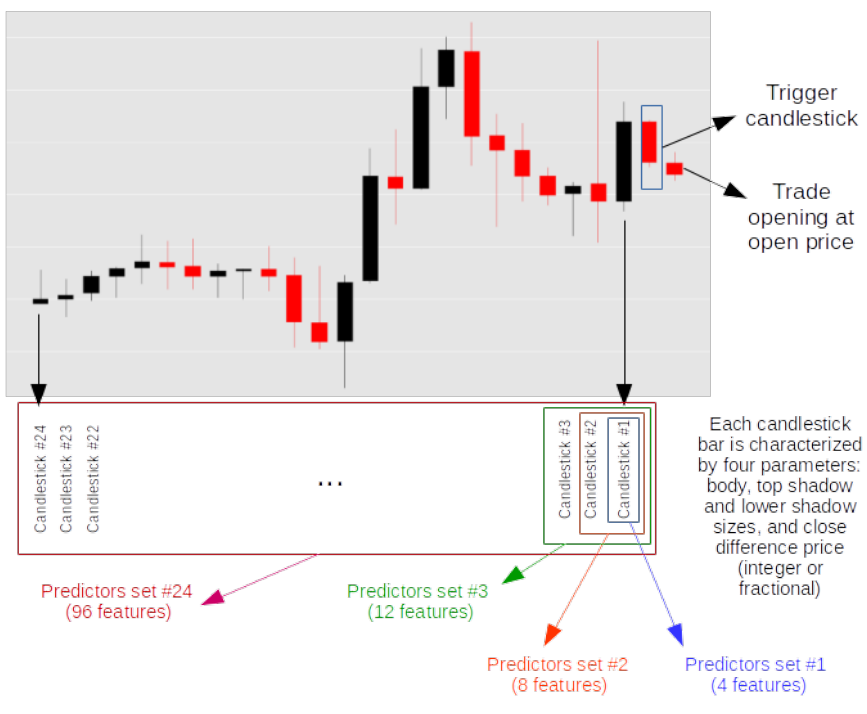
Figure 16. Set of 24 feature subsets per feature set (A or B) per model (six models) per value of coefficient c